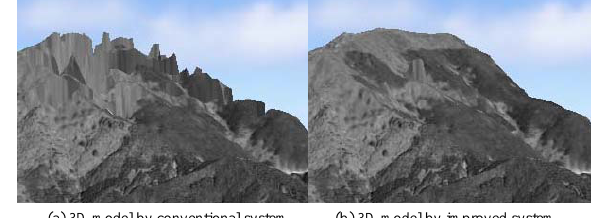
Figure 2. Concept Image of DTM Estimation